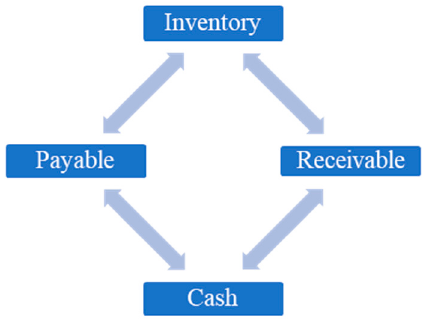
Figure 1. Working capital